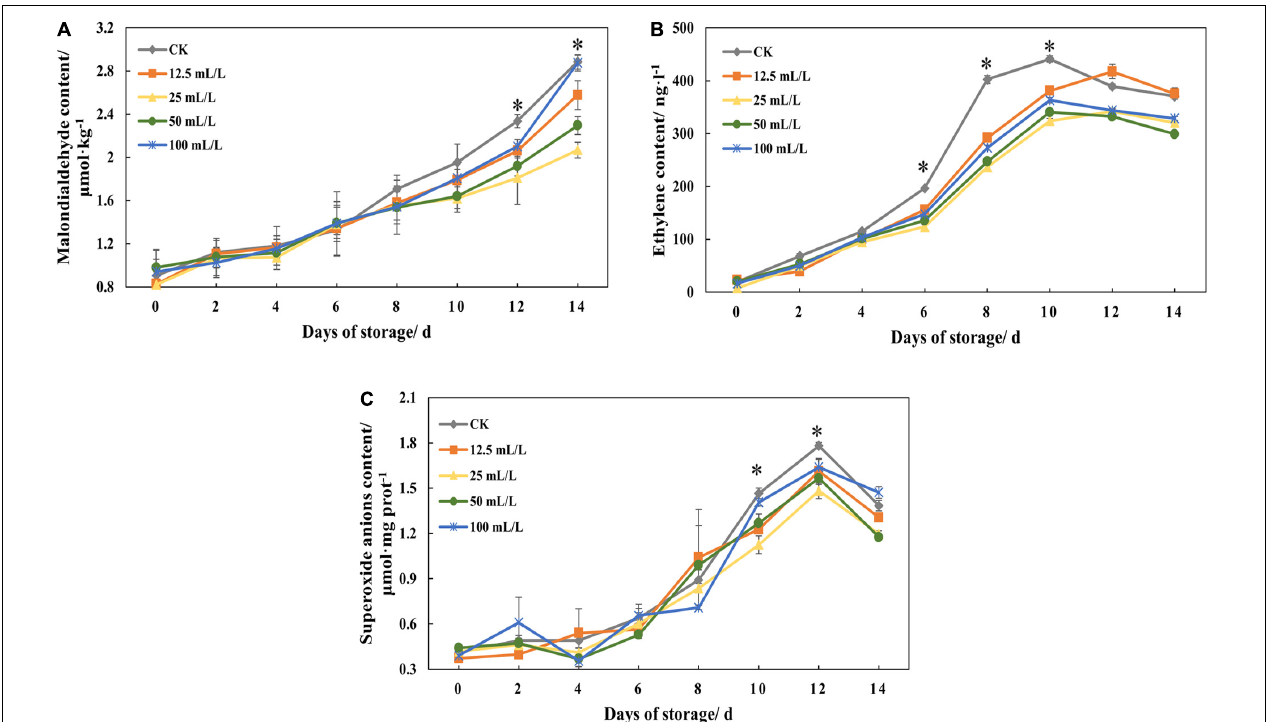
FIGURE 3 | (A) Malondialdehyde content, (B) ethylene content, and (C) superoxide anions content of papaya fruits treated with 0, 12.5, 25, 50, and 100 mL/L ethanol. Values are means ± SD. *Represents significant differences among the treatments ( p <